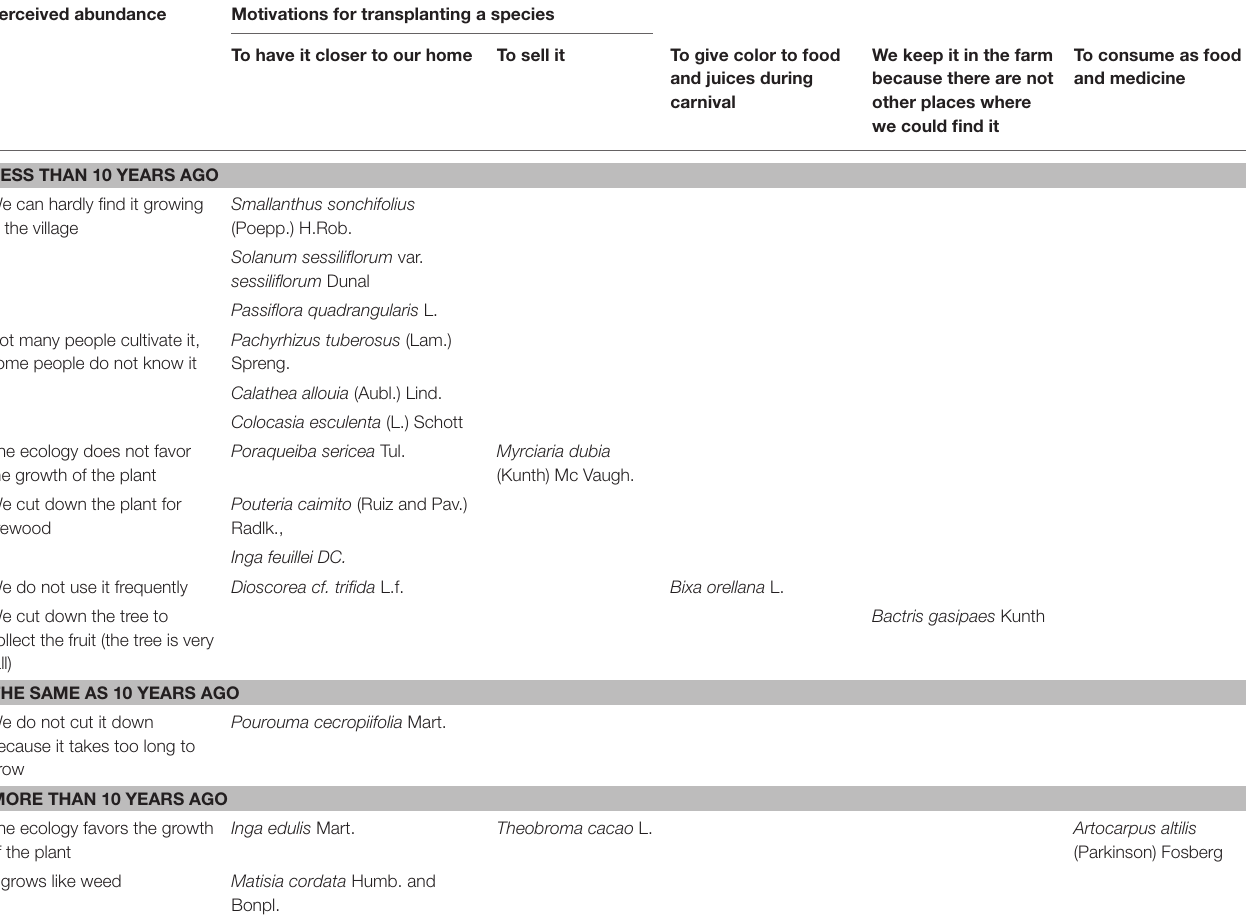
TABLE 4 | Farmers’ motivations for transplanting a “wild” food plant species in relation to perceived abundance ( n = 18). Perceived